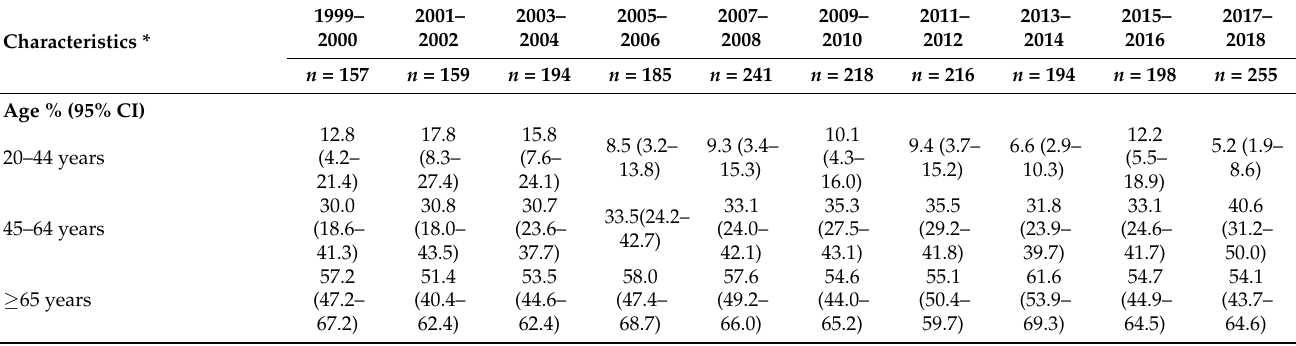
Table 1. Characteristics of Adults with a History of Stroke in the NHANES, 1999 to 2018.